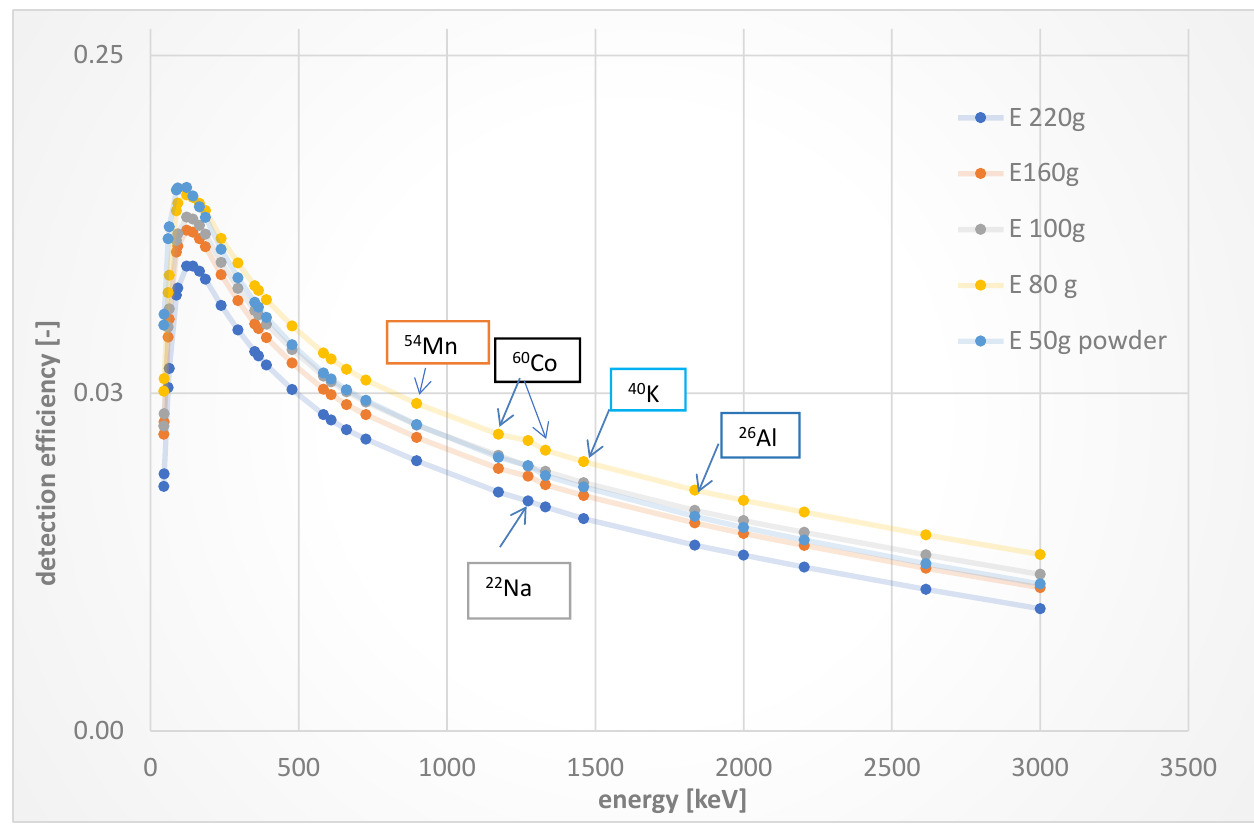
Figure 4. Detection efficiency curves for various meteorite geometries using LABSOCS (CANBERRA) software.